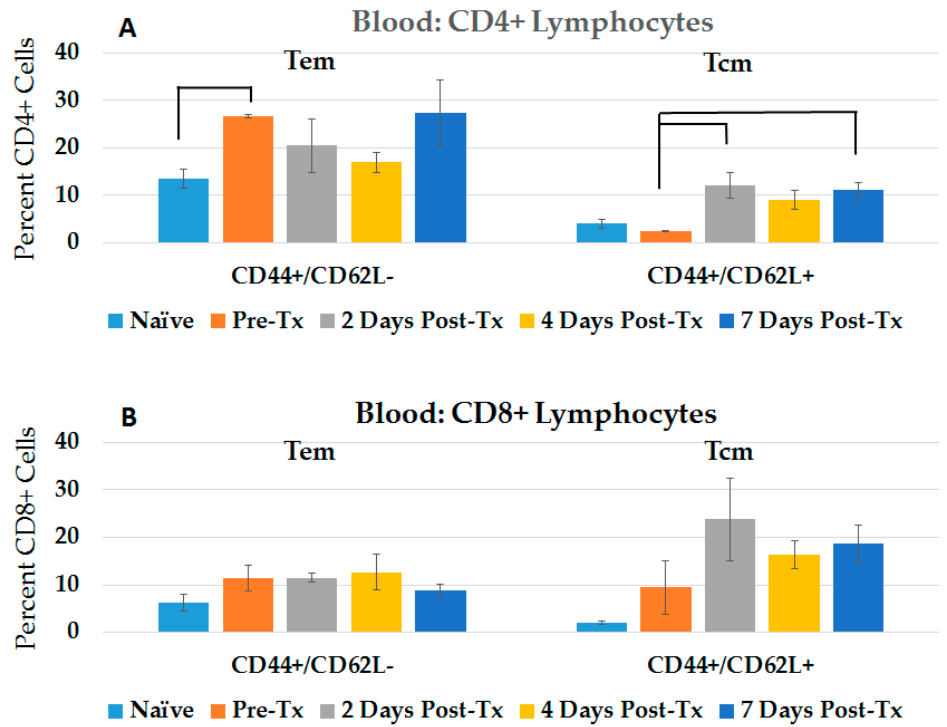
Figure 1. Circulating CD4+ and CD8+ Tem and Tcm increase in response to NPS. Blood was taken